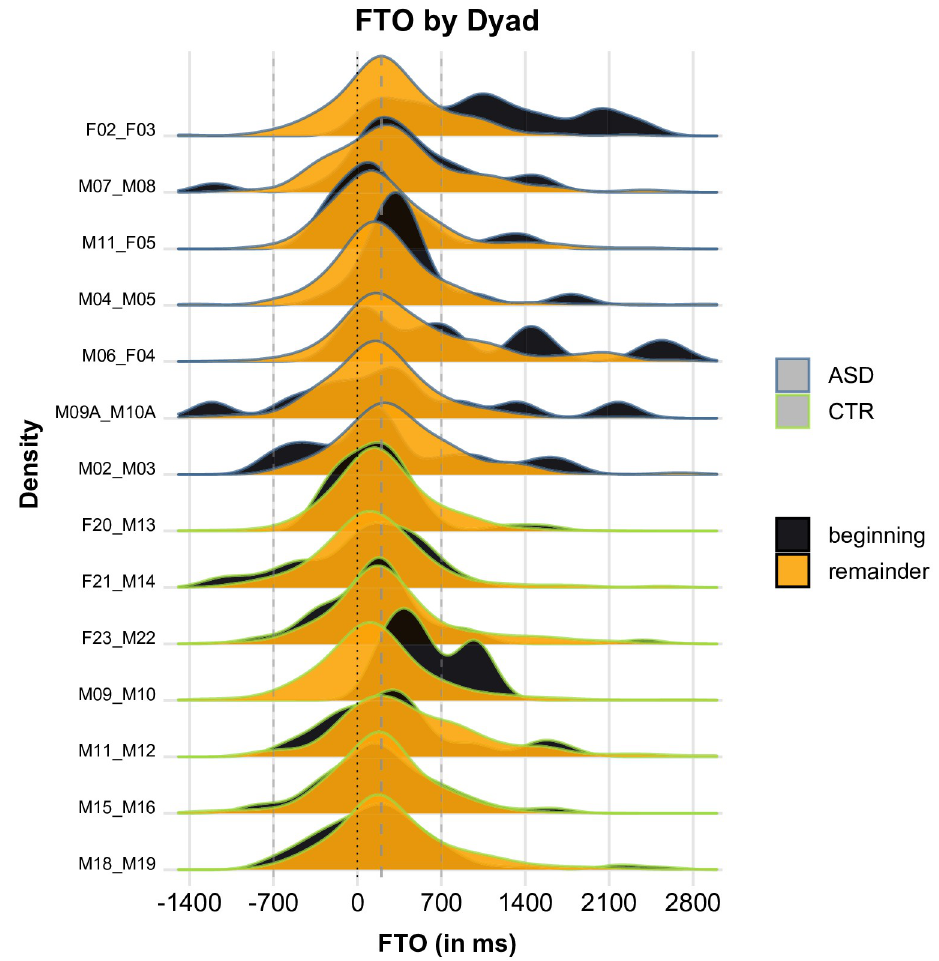
Fig 7. FTO values by dialogue stage and dyad. Positive values represent gaps; negative values represent overlaps. ASD dyads in the top half and outlined in blue, CTR dyads in the bottom half and outlined in green. Black curves represent the beginning of dialogue (before detection of the first Mismatch); orange curves represent the remaining dialogue (after detection of the first Mismatch).